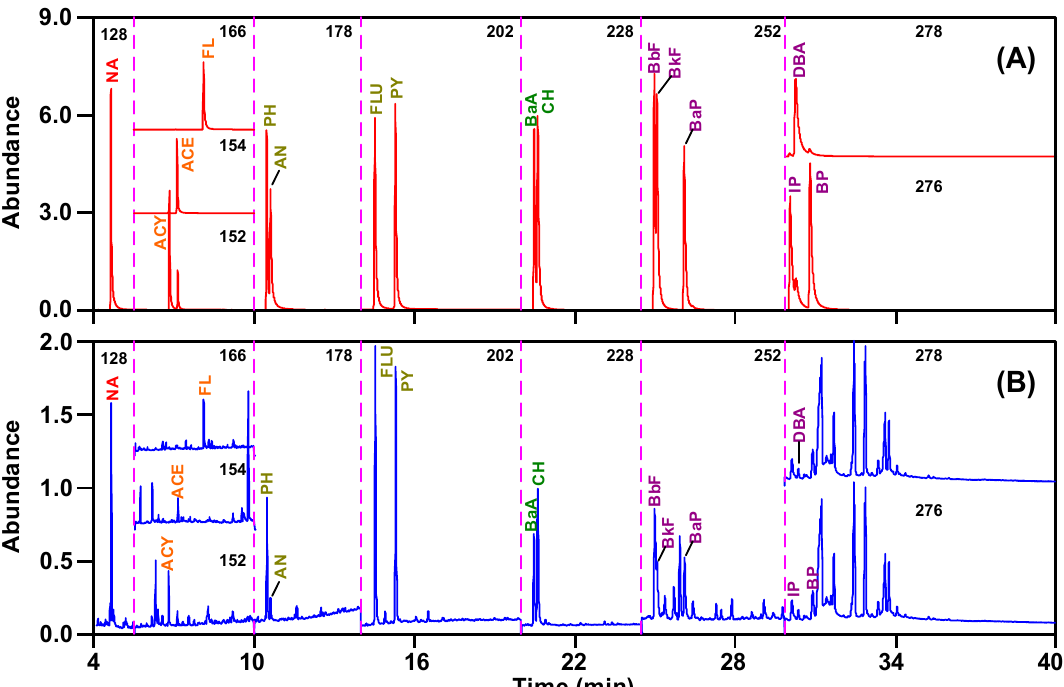
a Internal standard. b Surrogate standard. c Bold indicates quantitative ion.